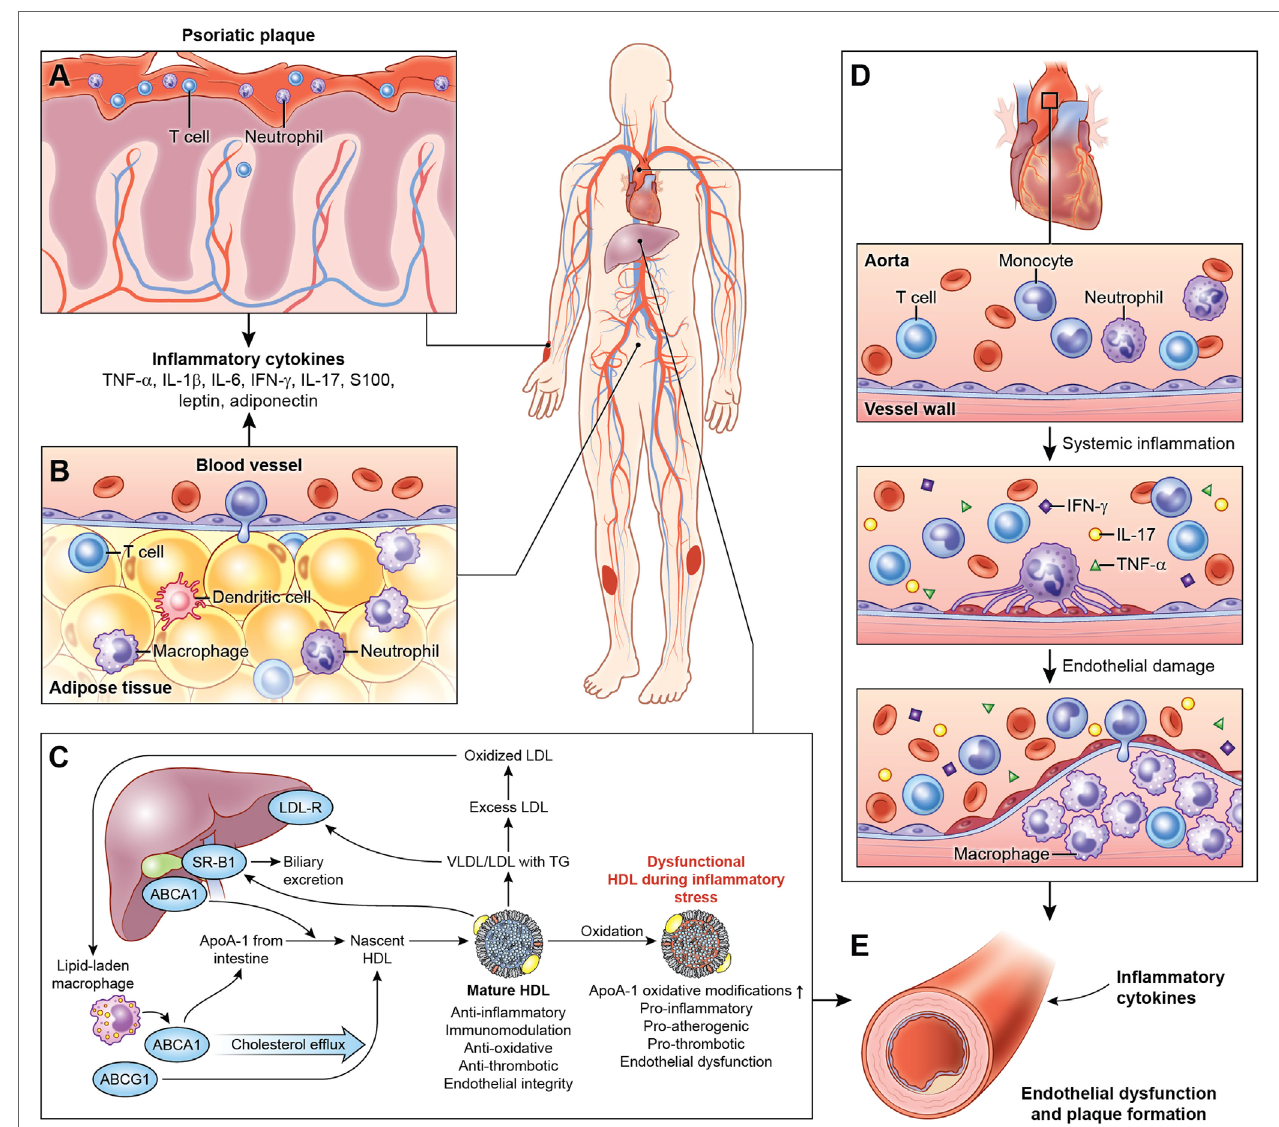
FiGURe 1 | Systemic effects of chronic low-grade inflammation in psoriasis. (A) Psoriasis, both cutaneous and arthritic, is a low-grade chronic, systemic inflammatory disease associated with increased circulating pro-inflammatory cytokines. (B) Chronic inflammation in psoriasis is associated with adipose tissue dysfunction characterized by pro-inflammatory cytokines and adipokines associated with endothelial dysfunction. (C) Furthermore, psoriasis exhibits a deranged lipid profile and impaired HDL function, which in combination with chronic inflammation accelerate atherosclerotic vascular disease. (D) The vessel wall is infiltrated through a complex interplay of pro-inflammatory cellular components, cholesterol crystals, and various lipoproteins. Over the time, with build-up of the plaque, this atherosclerotic lesion poses a significant threat to blood flow and is prone to rupture, often accelerated by inflammation leading to myocardial infarction. (e) Thus, psoriasis and psoriatic arthritis upregulate T-cell, neutrophil chemotaxis, and keratinocyte activation and endothelial dysfunction leading to increased atherosclerosis in blood vessels. Abbreviations: TNF- α , tumor necrosis factor-alpha; IL, interleukin; IFN- γ , interferon-gamma.